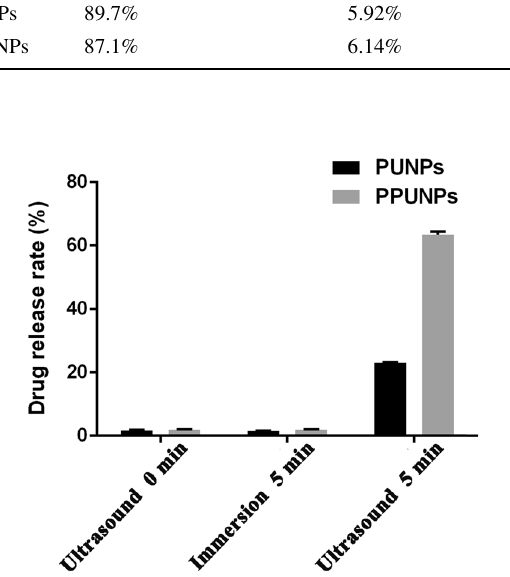
Fig. 2 In vitro UK release rates of PUNPs and PPUNPs after 0, 5 min of ultrasound treatment or 5 min immersion in the solution without ultrasound treatment ( n =